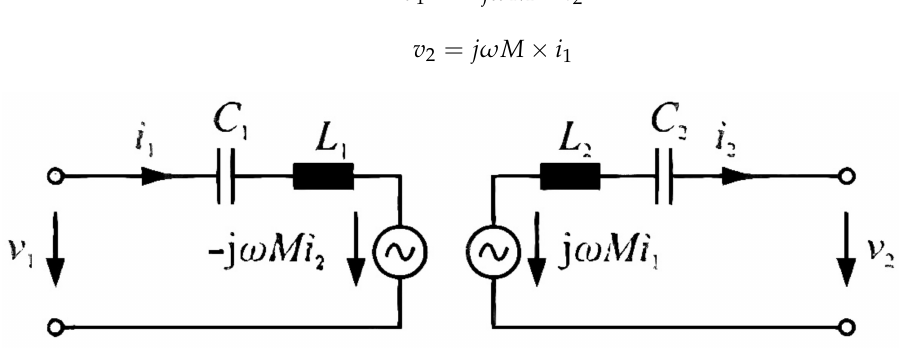
Figure 17. Equivalent circuit for fundamental frequency approximation of IPT [88].